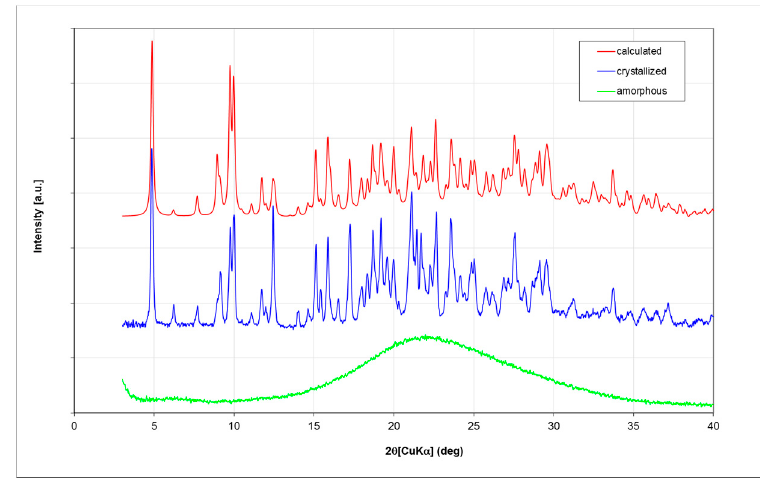
Figure 3. Comparison of the observed powder diffraction patterns of amorphous (green) and crystallized Fondaparinux (blue) with the pattern calculated from the single-crystal structure (red). The patterns are given an arbitrary displacement along the intensity axis to aid comparison. For the calculated pattern, the unit-cell parameters were refined using the Rietveld method to allow for the difference in data collection temperature. The reflection positions of observed and calculated patterns show a good correlation. The relative intensities show some differences, which are most likely due to the limited number of crystallites in the powder measurement, some preferred orientation effects and small changes in structure (especially in the water molecules) due to the temperature difference.